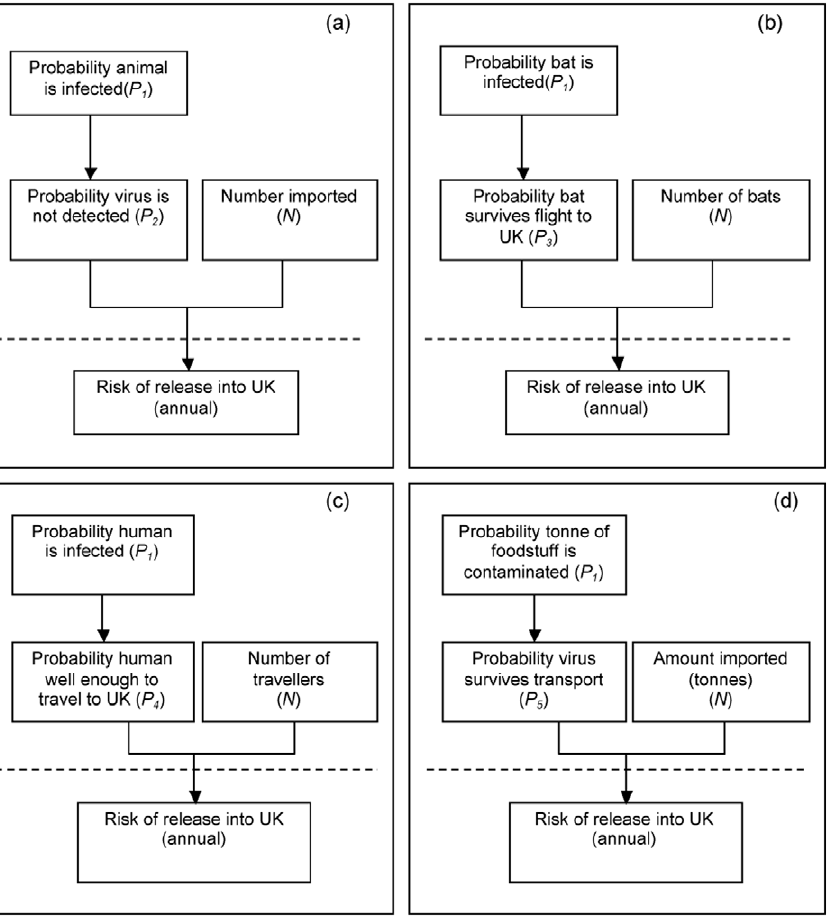
Figure 2. Release pathways for henipaviruses to be released into the UK via (a) imported bats (all species), pigs, horses and companion animals; (b) ‘‘natural importation’’ of insectivorous bats; (c) via human travel; (d) via a tonne of imported foodstuffs.